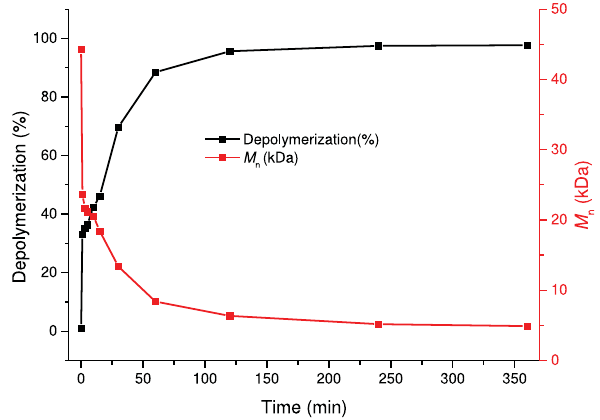
Fig. 7 | Kinetic studiesofSP1 depolymerization. Percentage ofdepolymerization (inblack)andnumber-averagemolecularweightoftheresidualpolymer(inred)as a function of